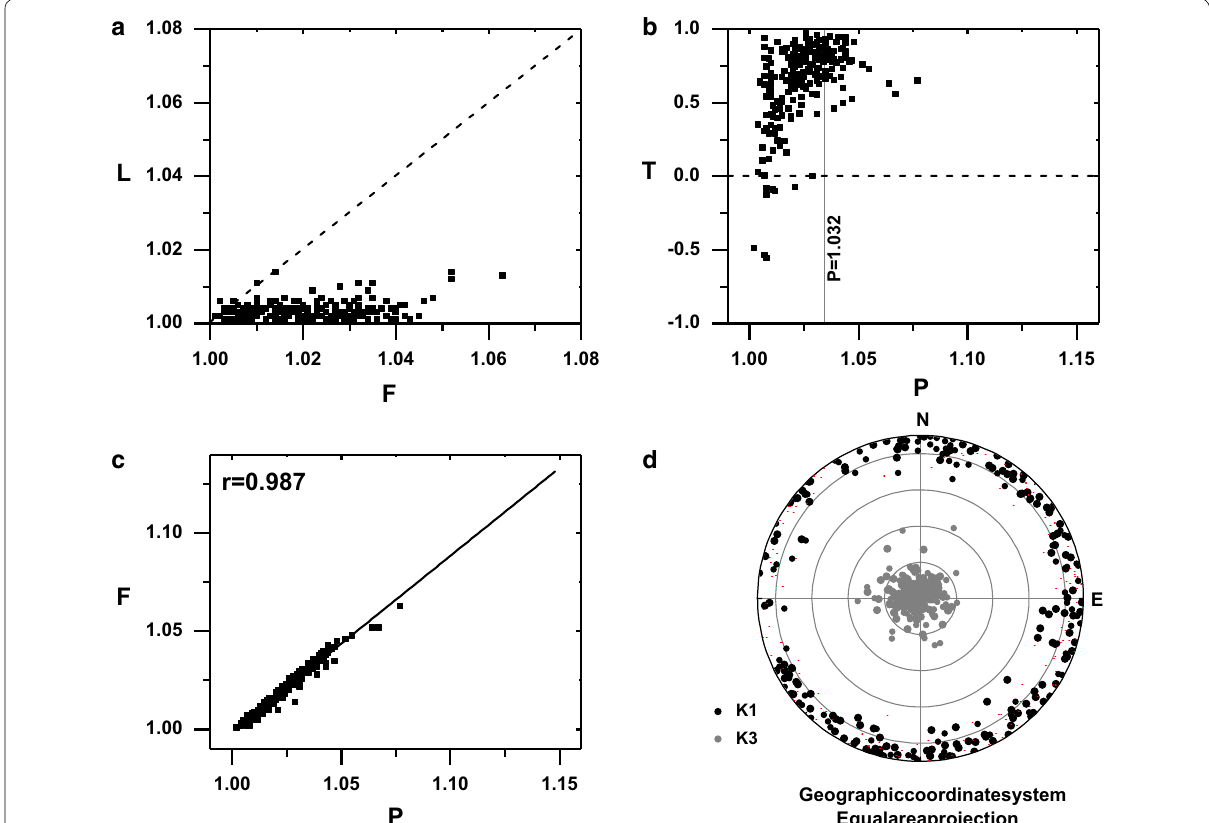
Fig. 4 a – c Bivariate relations of typical AMS parameters ( L lineation, F foliation, P anisotropy degree); and d equal-area projection of AMS principal axes for all samples (black and gray circles represent k1 and k3 axes,